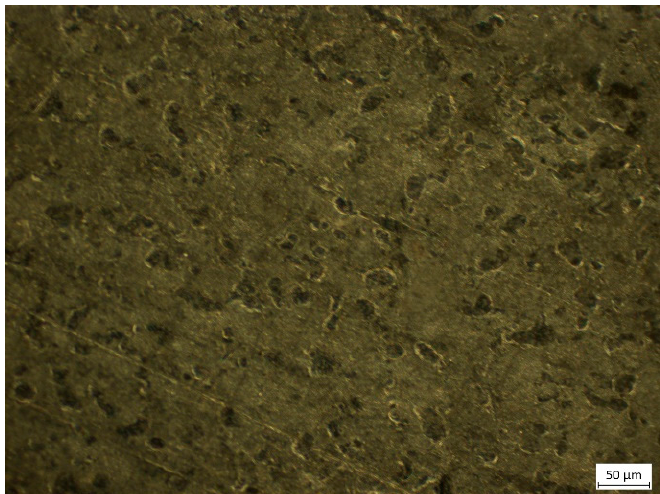
Figure 2. The surface view of a metal sheet from a metallographic microscope AX ZEISS @ 200X.